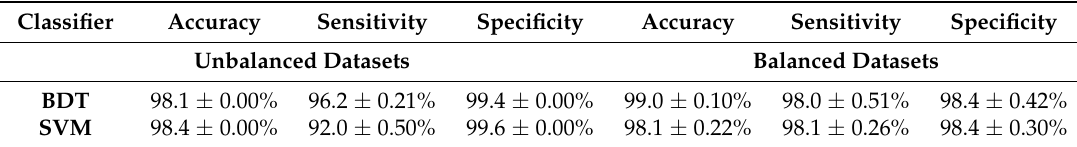
Table 8. Performance of stage 3: PVC